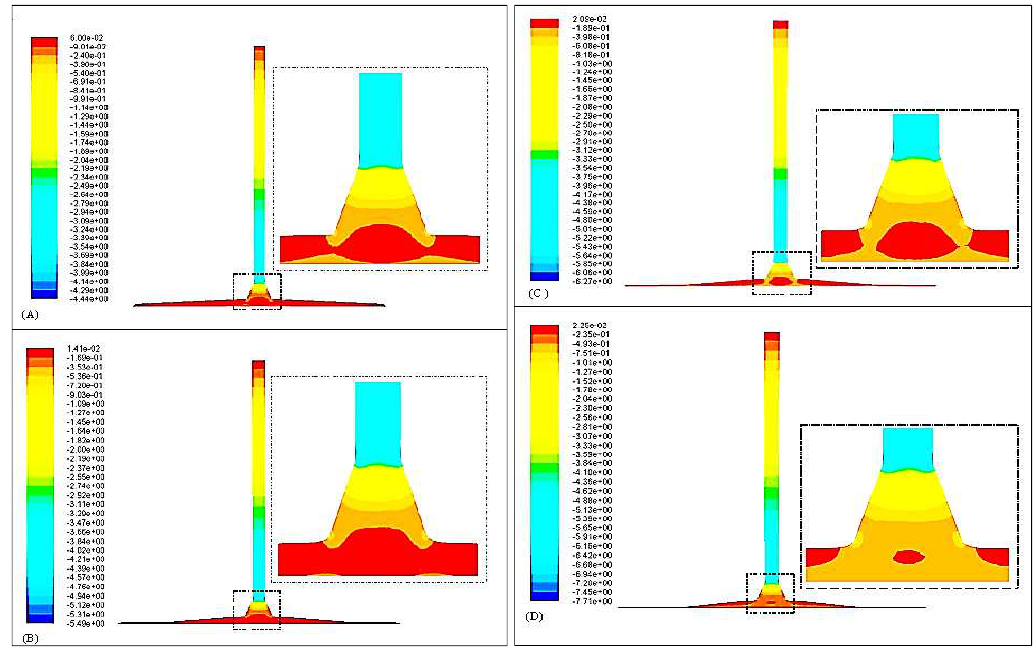
Fig. 15. Contours of static pressure(pa) (A)without reduction area.(B)at h1=3.8cm.( C) at h2=2.6cm. (D) at